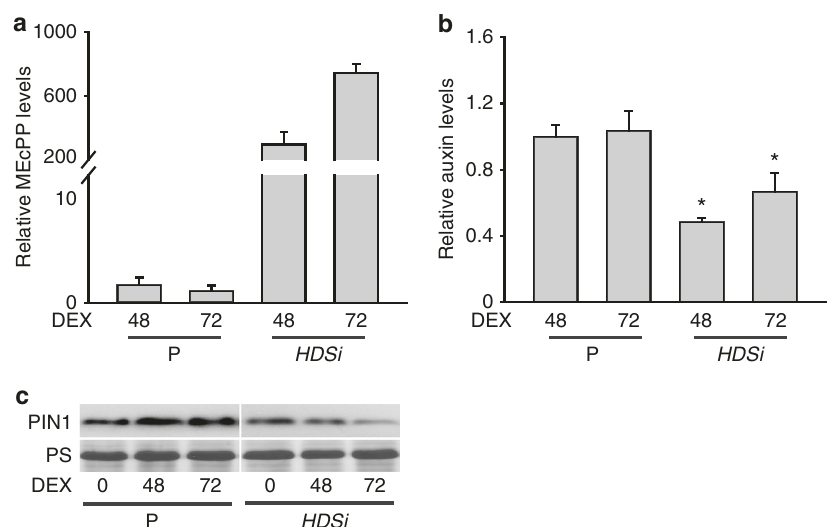
Fig. 3 Accumulation of MEcPP in inducible HDSi correlates with reduction of auxin and PIN1 abundance. a Levels of MEcPP in P and HDSi at 48 h and 72 h post DEX induction relative to un-induced seedlings. b Levels of auxin in P and HDSi at 48 h and 72 h post DEX induction relative to un-induced seedlings. c Protein levels of PIN1 in P and HDSi before and at 48 h and 72 h post DEX induction. Ponceau S (PS) staining displays equal protein